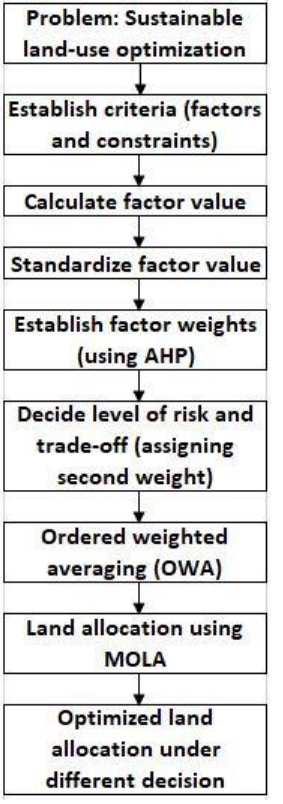
Figure 2. Land-use optimization process using the MCDM approach.